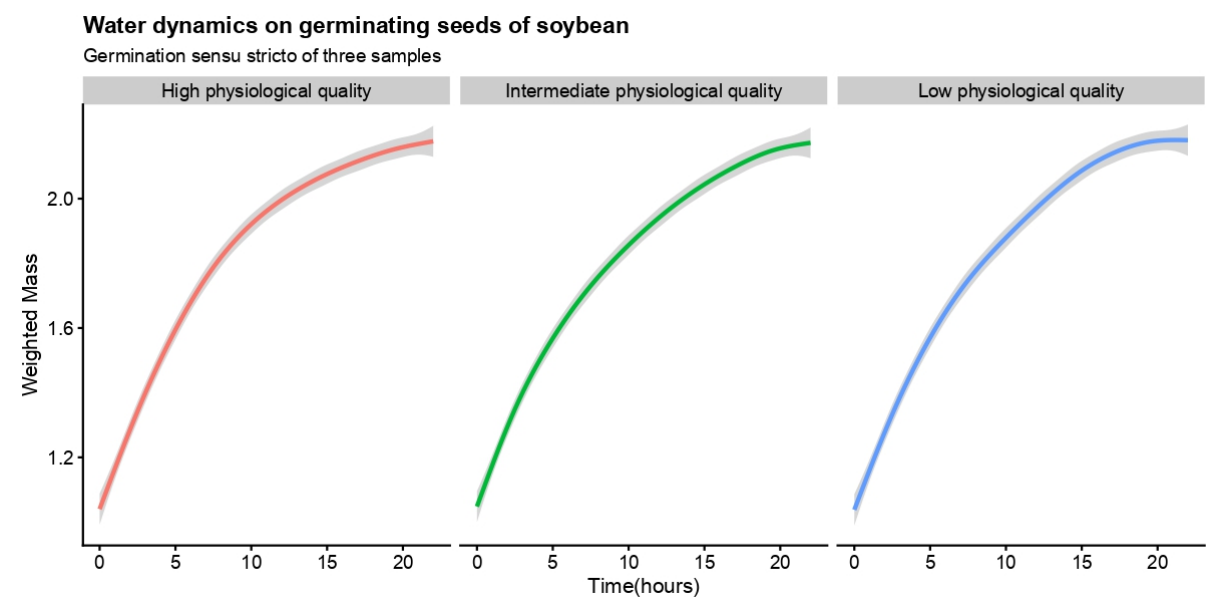
Figure 1. Water dynamics in germinating seeds of soybean based on weighted mass over time. Physiological quality de ‐ scribes viability (V) and germinability (G) in the sample from pre ‐ testing: High physiological quality is related to a seed sample with viability (V) and germinability (G) higher than 90%, intermediate physiological quality is a seed sample with 61% ≤ V ≤ 89%9 and 51% ≤ G ≤ 89%, and low physiological quality is a seed sample with V ≤ 60% and G ≤ 50%. The solid line (red, green and blue) shows the mean value, and the gray area delimits the lower and upper confidence intervals from 1000 Monte Carlo simulations at 0.05. The embryo protrusion in at least one sample occurred 2 h before the last recording. n = 50 diaspores.